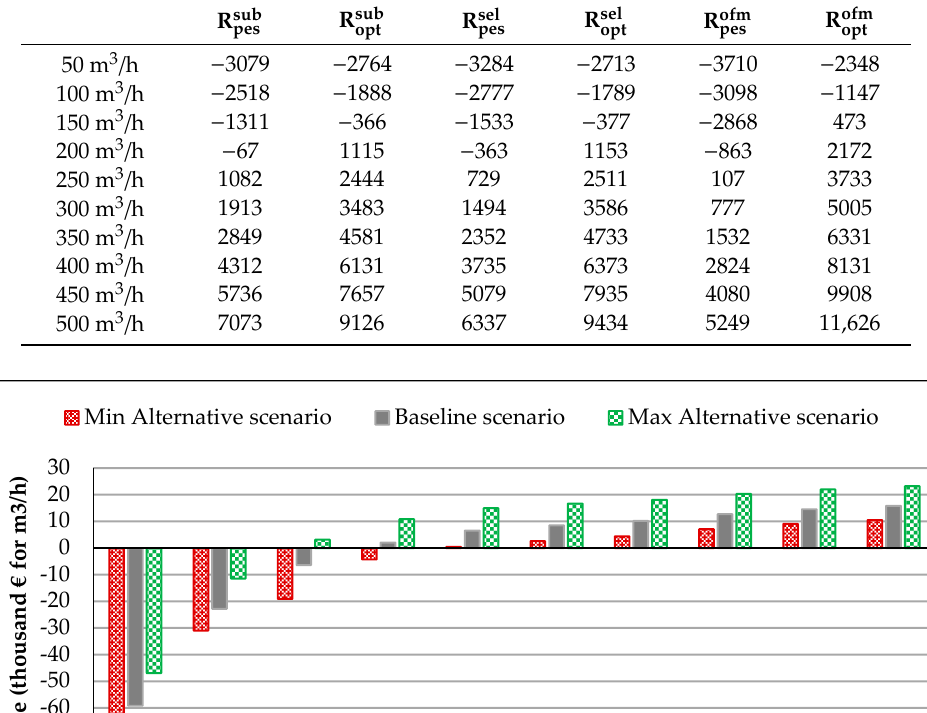
Table 5. Profitability analysis of biomethane plants (thousand € )—alternative scenarios.